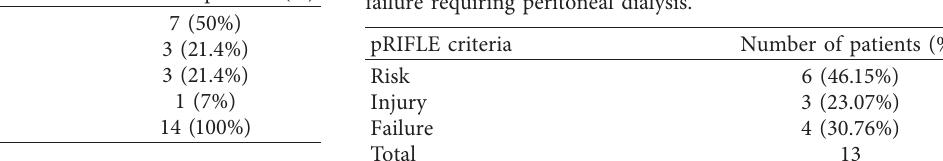
Table 4: Types of proteinuria in patients with dengue fever. Protienuria